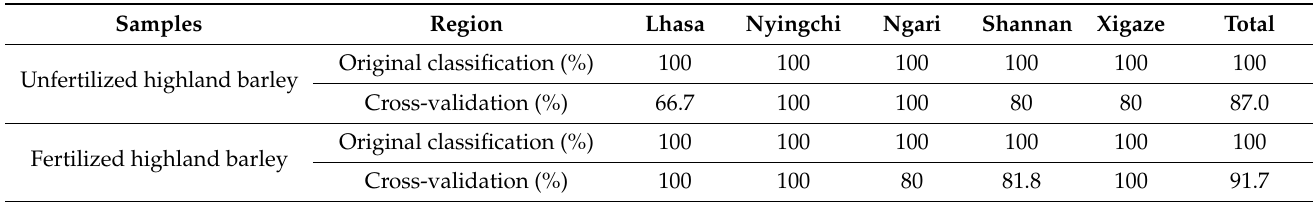
Table 3. Classification of highland barley samples based on nutrients and mineral elements values by LDA.